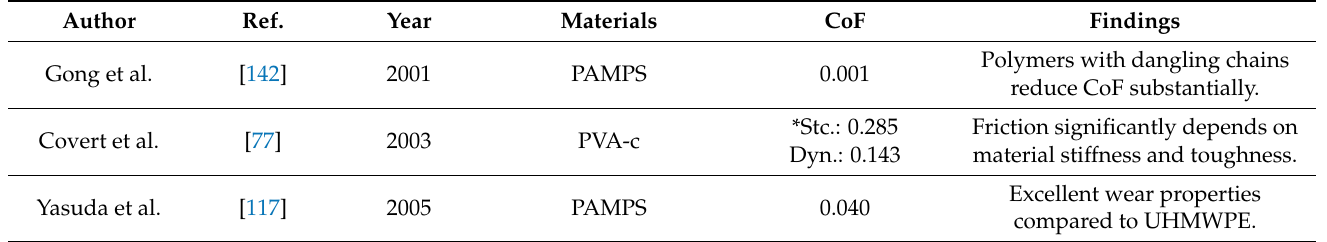
Table 4. Effects of monomers and polymers materials on hydrogels’